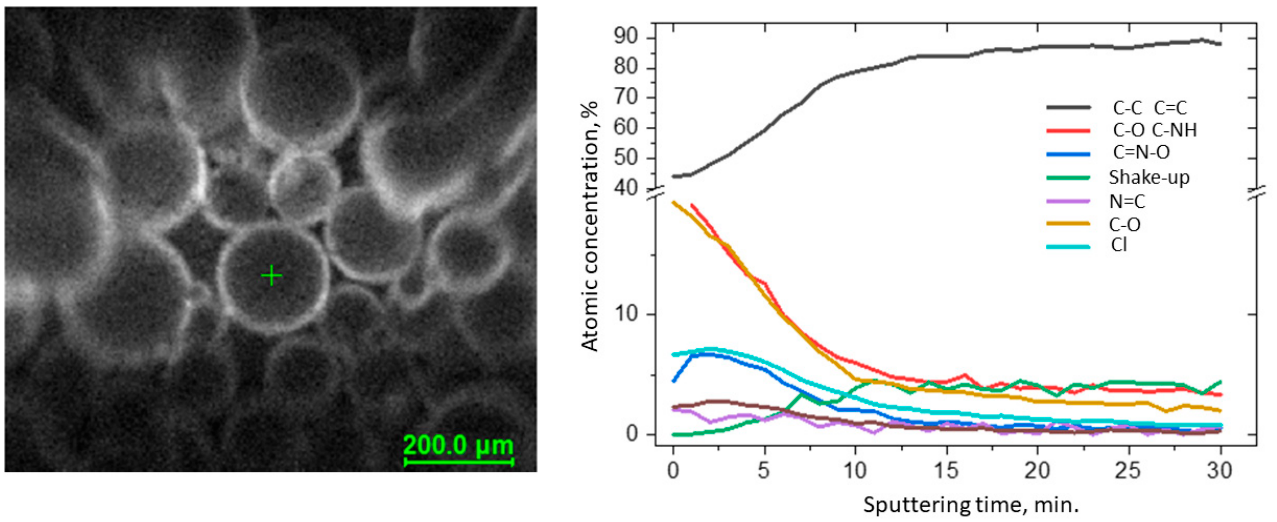
Figure 2. Results of the XPS depth profiling study of VBC-D4EI.